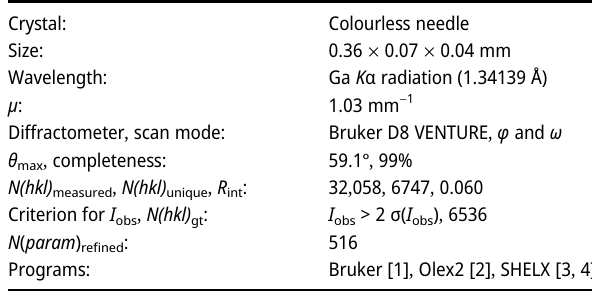
Table  : Data collection and